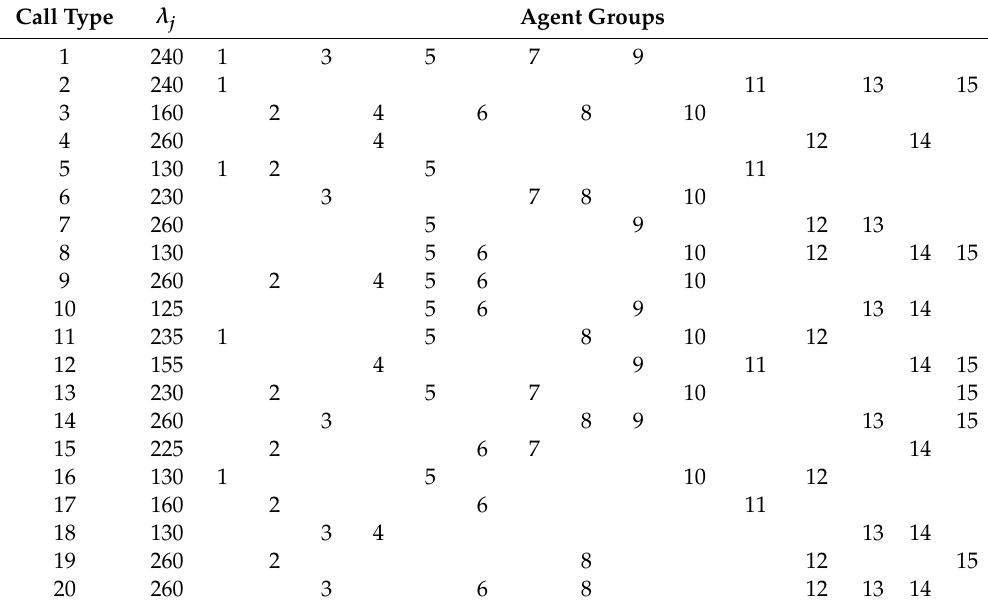
Table 2. Skill groups of the large problem.